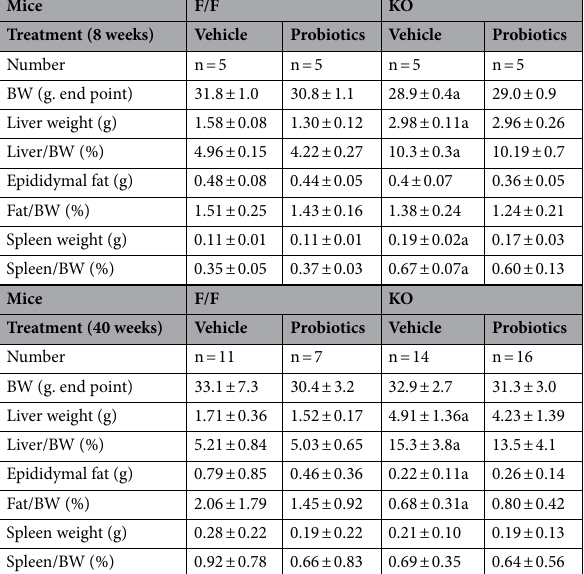
Table 1. Metabolic parameters in mice. Pten flox/flox mice (F/F) and PTEN KO mice (KO) were fed with normal water (vehicle) or probiotics for 8 or 40 weeks. BW, body weight; F/F, Pten flox/flox mice; KO, PTEN KO mice. Groups were analyzed using one-way analysis of variance and the Tukey post-hoc test. Data were presented as mean ± standard deviation. a Significantly different from F/F among